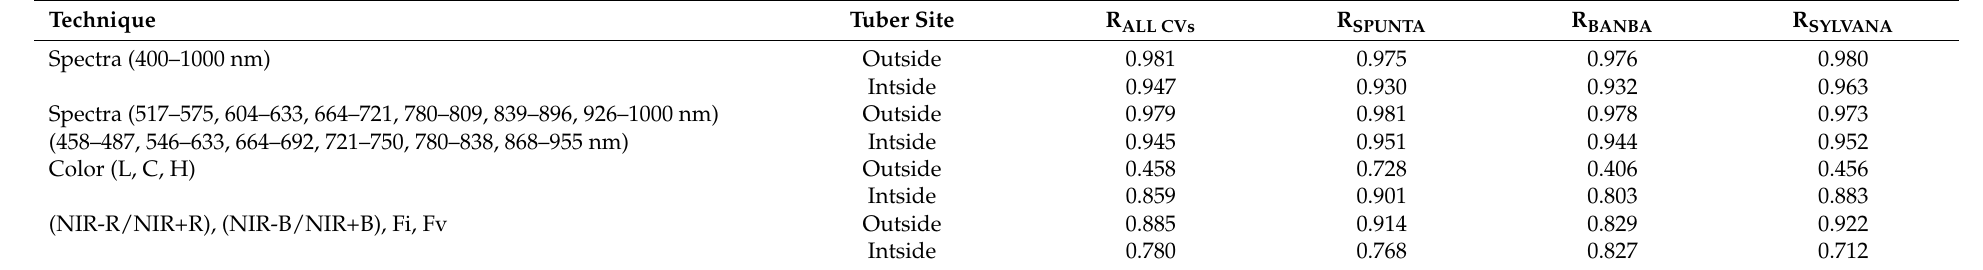
Table 1. Regression coefficients (R) of cross-validated partial least square analysis between storage period (0, 2.5, and 5 months) and color, digital imaging, and chlorophyll fluorescence as well as Vis/NIR spectroscopy data of the whole 400–1000 nm and the genetic algorithm (GA) selected regions. Data were either pooled from all three varieties (Spunta, Banba, or Sylvana) or individually within each one of